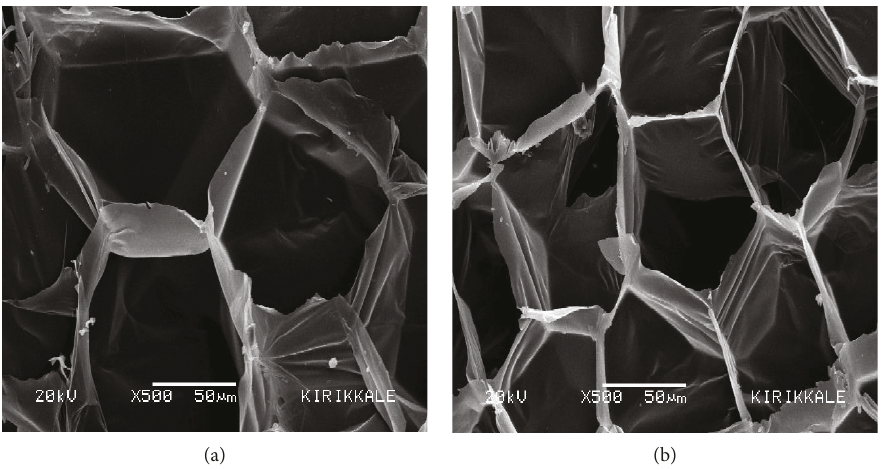
Figure 6: X500 microstructure image for the expanded polystyrene: (a) 16kg/m 3 and (b) 21kg/m 3